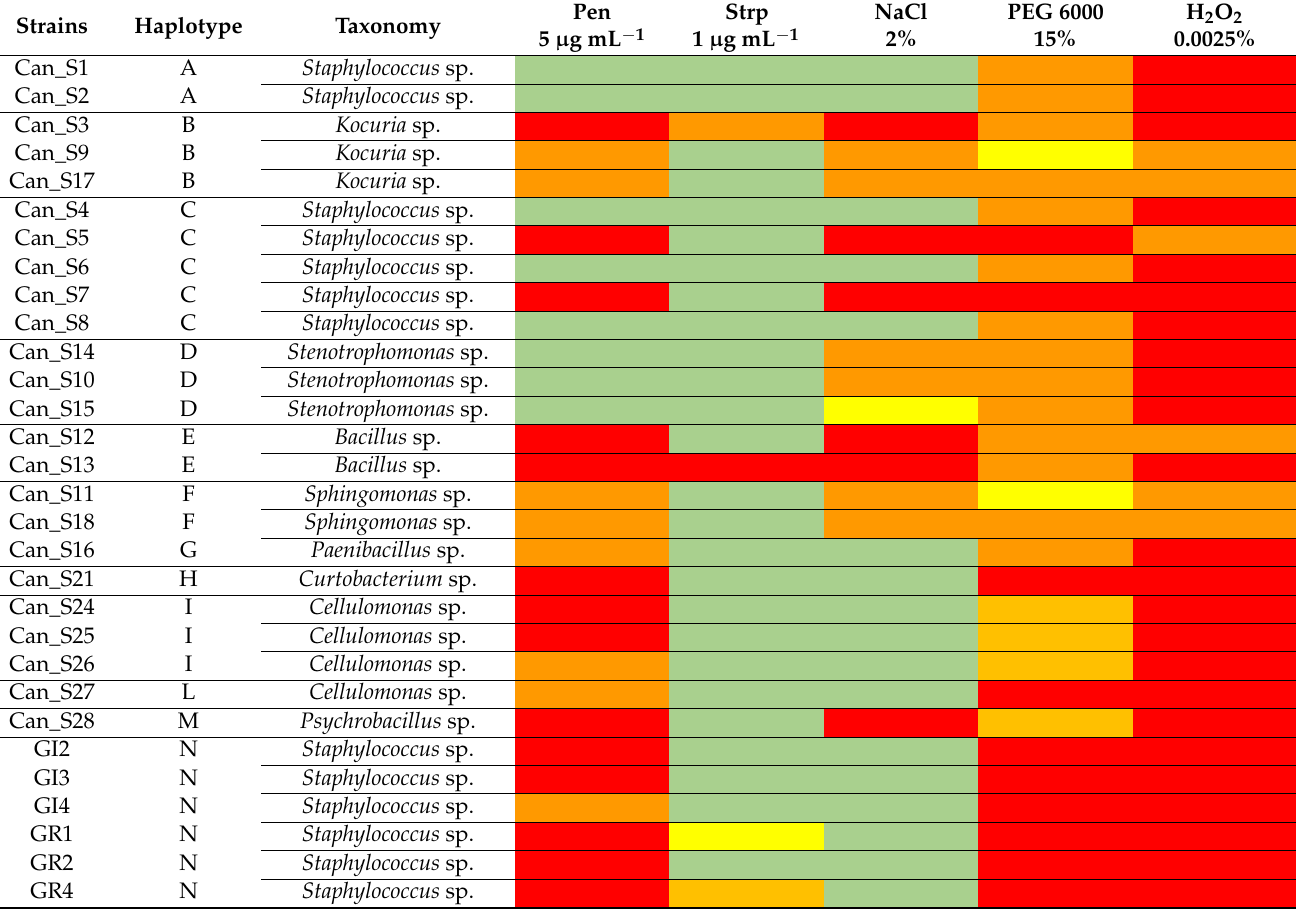
Table 2. Stress tolerance patterns against 5 µ g mL − 1 penicillin (pen), 1 µ g mL − 1 streptomycin (strp), 2% NaCl, 15% PEG 6000, and 0.0025% H 2 O 2 . Growth values below 10% (red color) correspond to the “absence of growth”, growth values between 10 and 50% (orange color) correspond to “weak